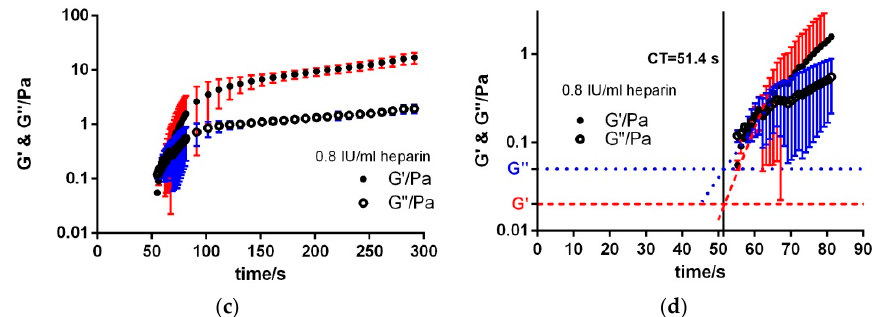
Figure A1. Repeatability measurements of citrated blood with additional heparin activated by Thromborel. Mean elastic and viscous shear moduli of citrated and heparinised ( a ) 0.5 IU/mL, ( c ) 0.8 IU/mL) blood activated with Thromborel ( n = 10 ± SD) are shown over time. The measurement was performed at a shear stress of 0.04 Pa with 1 Hz and a 1°/40 mm stainless steel cone geometry; ( b , d ) Enlarged parts from diagrams ( a , c ), respectively. The dashed red line at 0.02 Pa visualises the elastic shear modulus and the dotted blue line at 0.05 Pa the viscous shear modulus of uncoagulated citrated blood with no coagulation activator. After the addition of the activator Thromborel the increase of G ′ and G ″ was smaller than without heparin. The inhibitor heparin prolonged the clotting time (CT, black solid line) in comparison to the reference measurement.